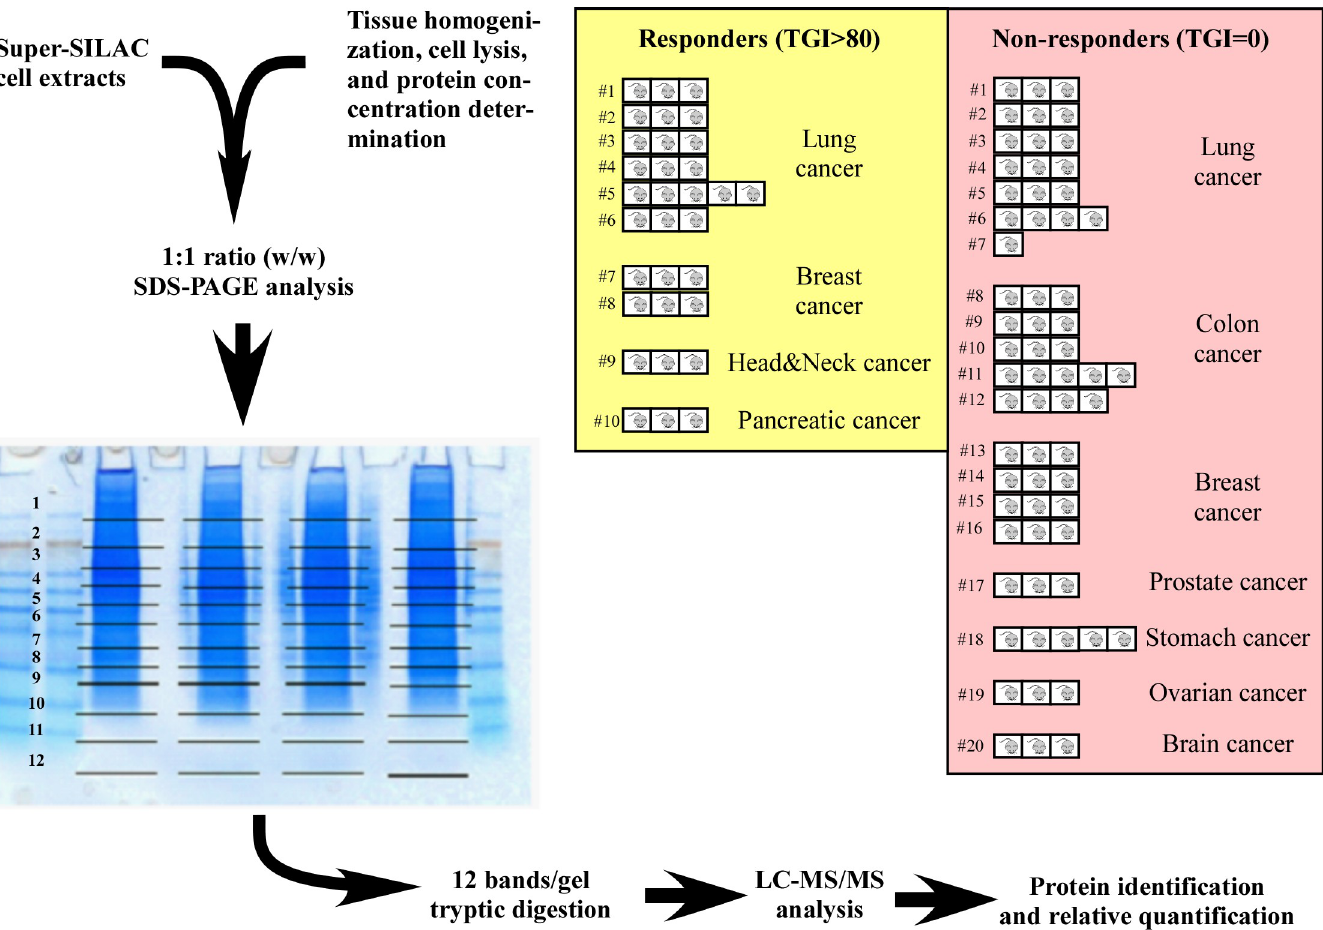
Fig 1. Proteomics strategy leading to the discovery of the 5-protein signature predictive to lumretuzumab activity. Cell- or patient-derived xenografts responsive (TGI > 80) or resistant to lumretuzumab activity were lysed and mixed 1:1 (w/w) with super-SILAC-labelled cell extracts [17] prior to SDS-PAGE fractionation, tryptic digestion, and LC-MS/MS analysis. Protein identification and quantification relative to the super-SILAC standards was performed as previously described [17]. The lineage and the number of different cell- and patient-derived xenograft models included in the discovery step are indicated, as is the number of replicates per xenograft